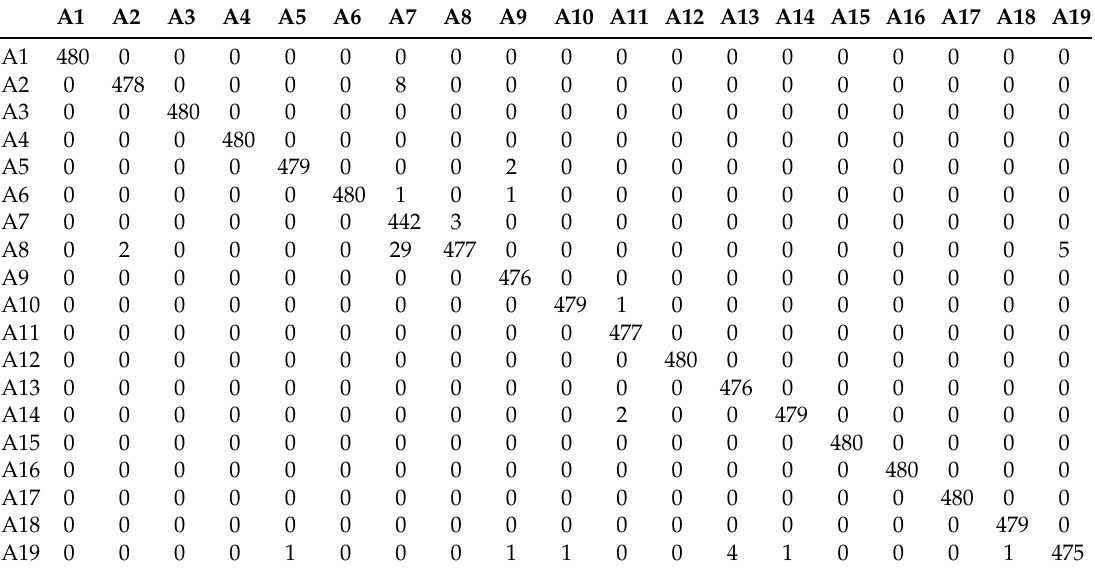
Table 2. Confusion matrix of training.